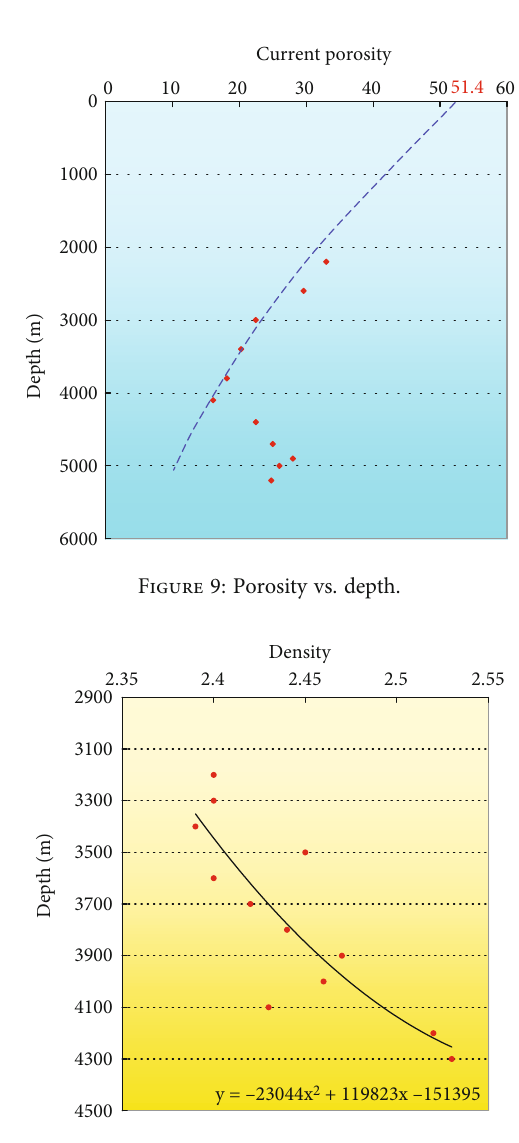
Figure 10: Density vs.